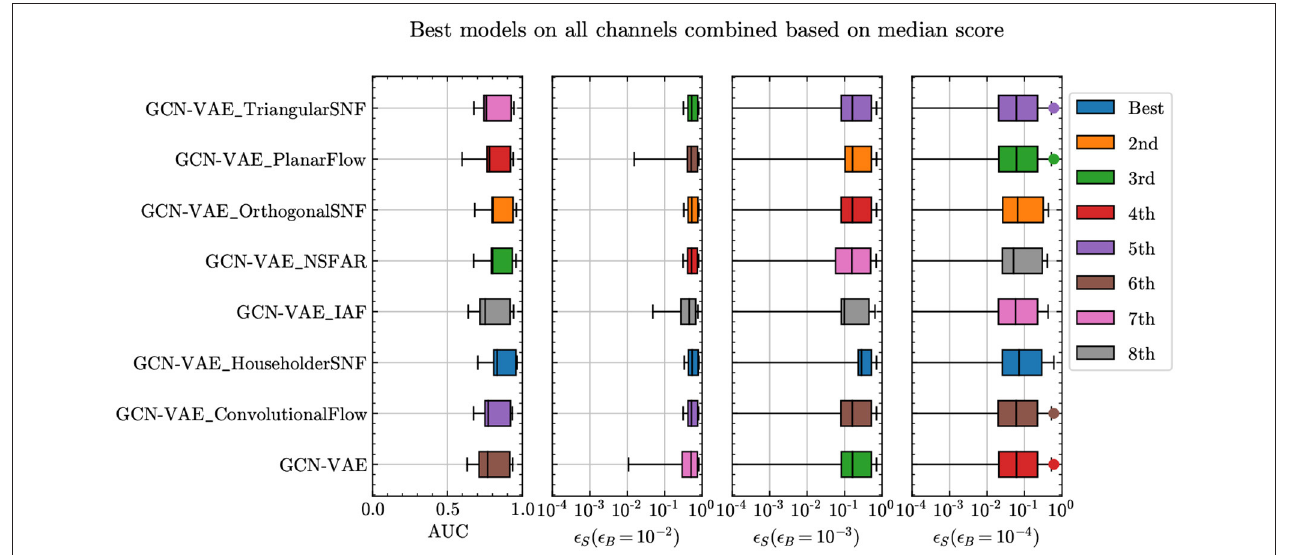
FIGURE 6 | Comparison of anomaly detection performance for GCN-VAE models with different normalizing flow architectures in the latent